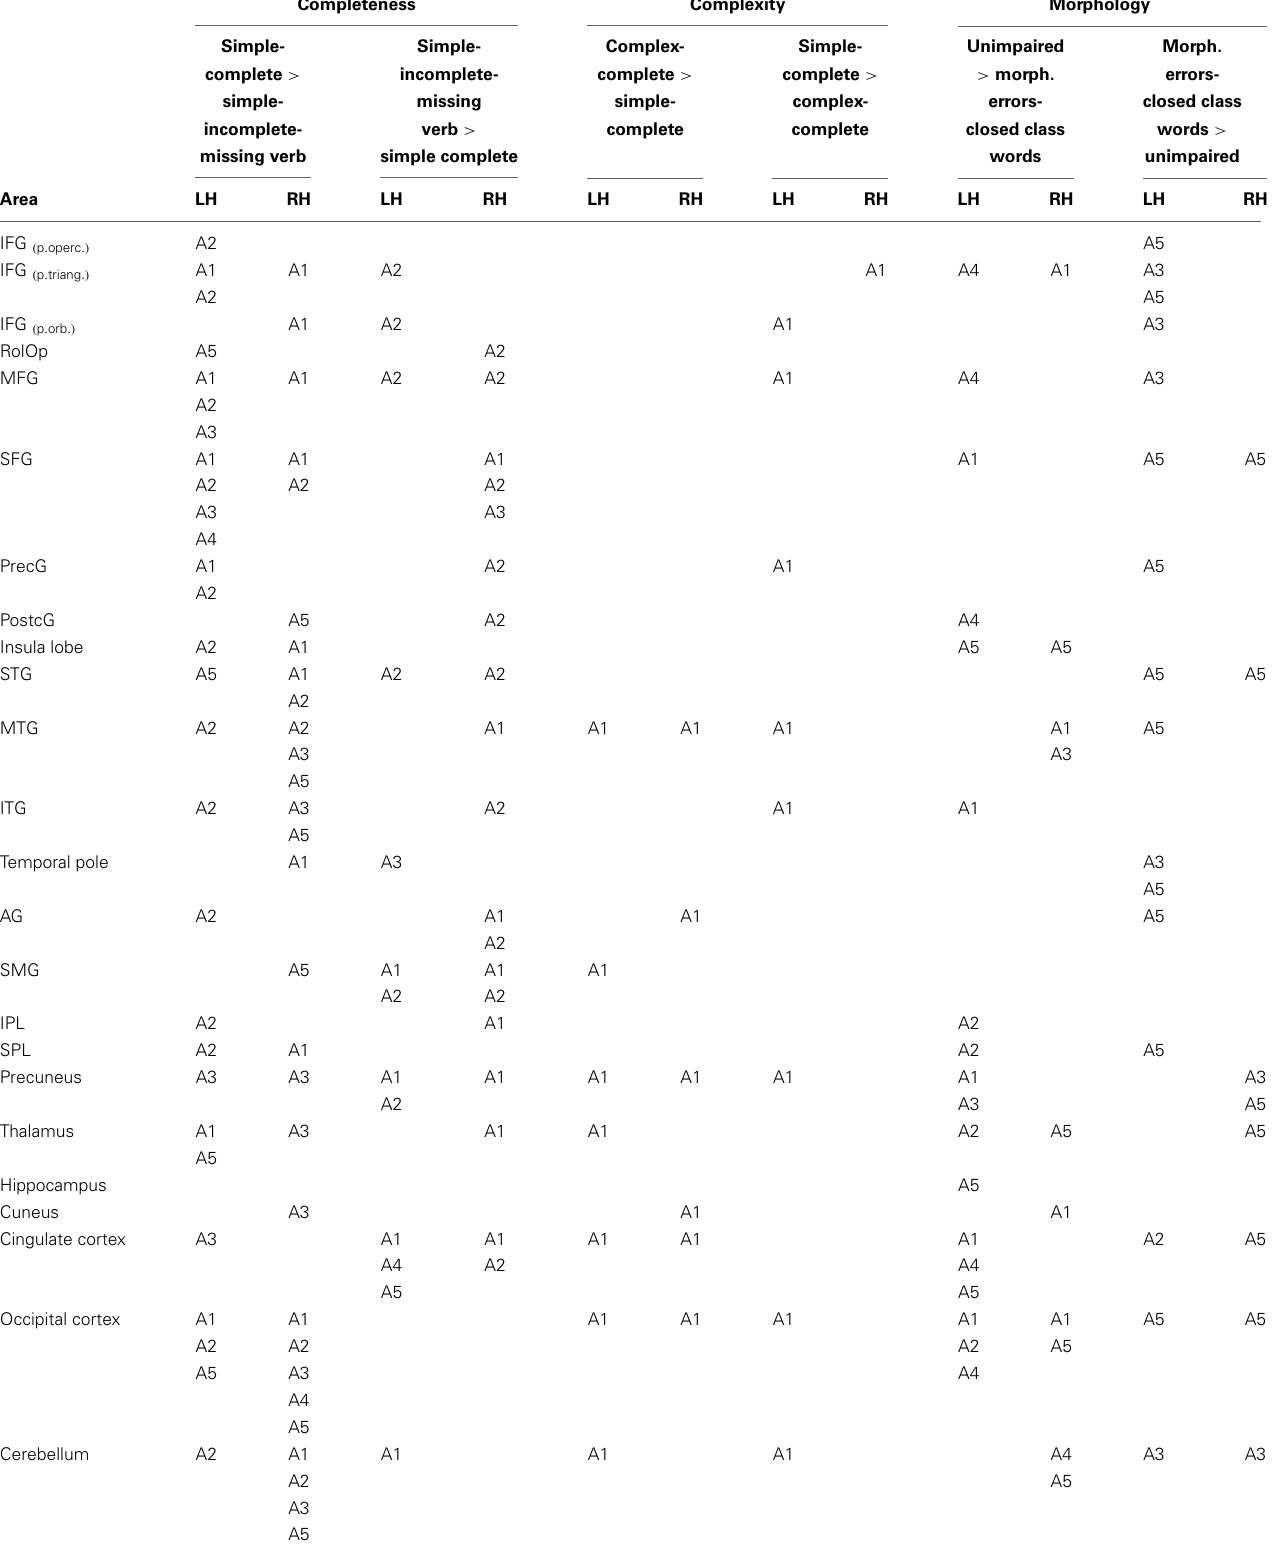
Table 6 | Aphasic speakers showing significant fMRI activation differences by region and contrast at P < 0 . 01 uncorr , extend threshold k ≥ 27 voxels based on Monte Carlo